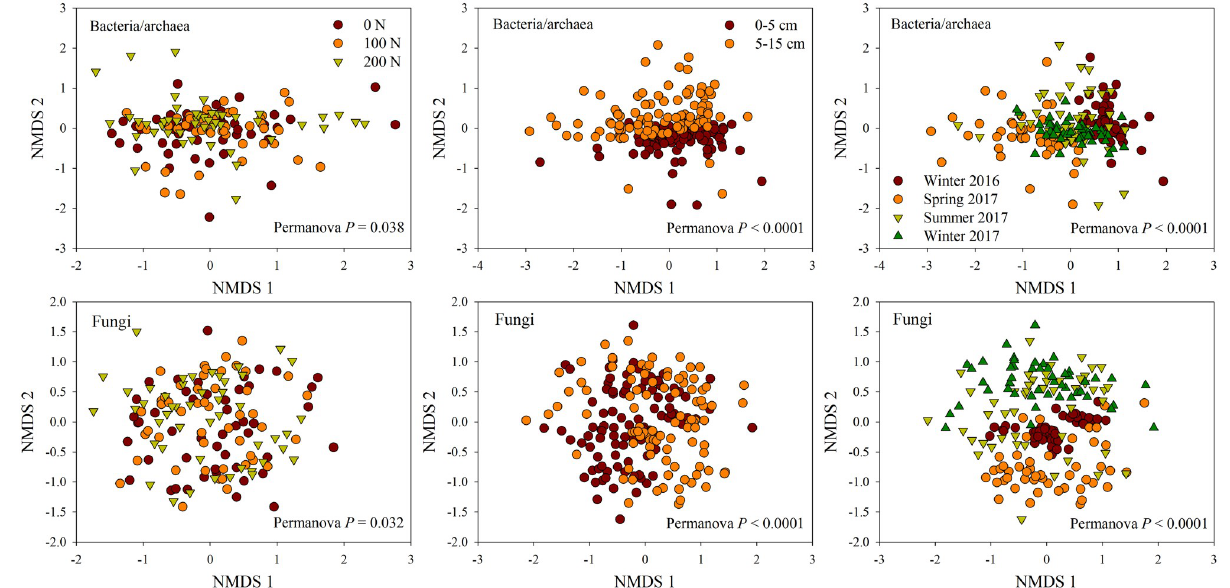
Fig 4. Non-metric multidimensional scaling (NMDS) analysis of bacterial/archaeal and fungal communities affected by three N fertilization levels (0, 100, and 200 kg N ha -1 ), two soil depth (0–5 and 5–15 cm), and four sampling seasons (Winter 2016, Spring, Summer, and Fall 2017). PERMANOVA P values were also